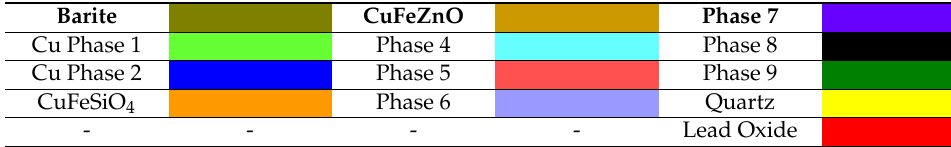
Table 4. AMICS elemental composition data for FF-ESP dust.